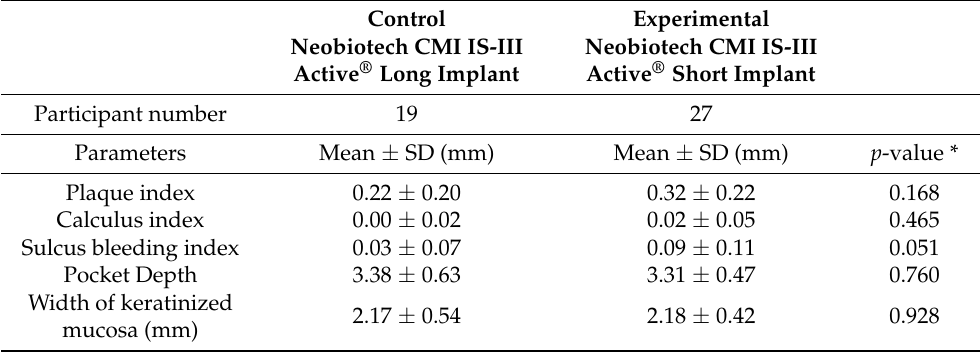
Table 4. Comparison of peri-implant soft tissue parameters between the long and short implants after 1-year